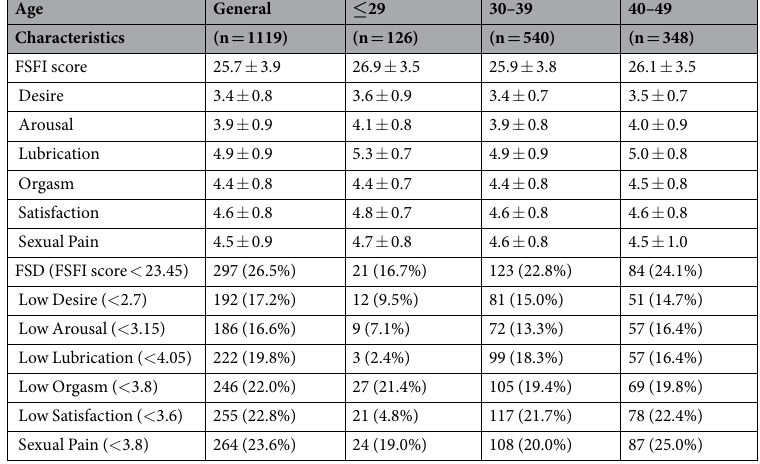
Table 2. The FSFI score and prevalence of FSD in each age category. FSFI: Female Sexual Function Index ; FSD: female sexual dysfunction.